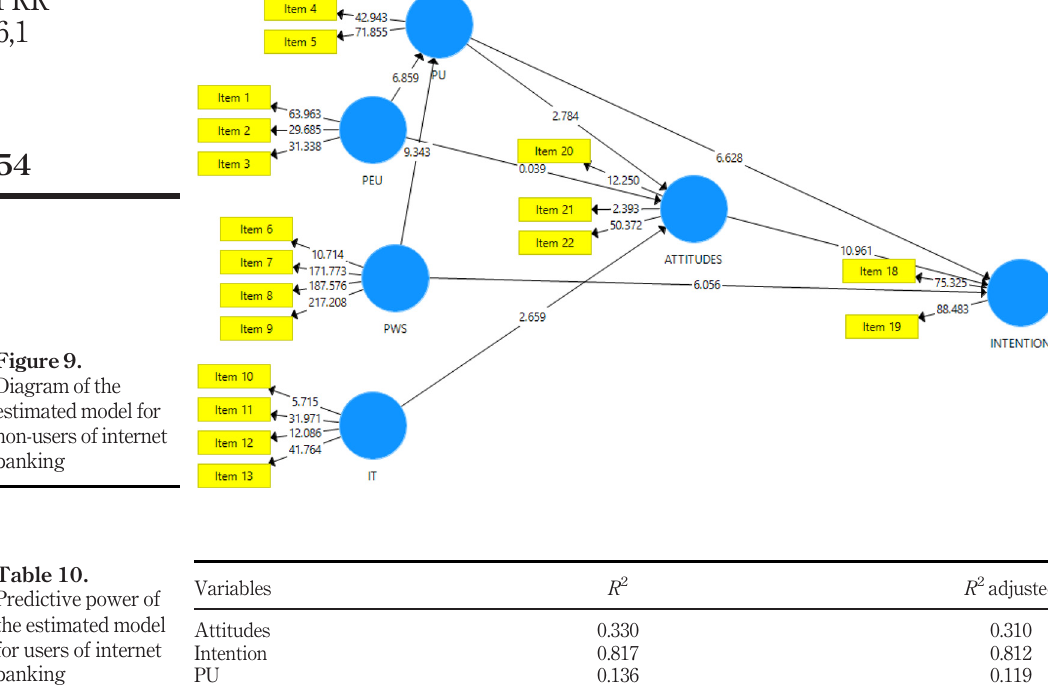
Table 11. Predictive power of the estimated model for non-users of internet